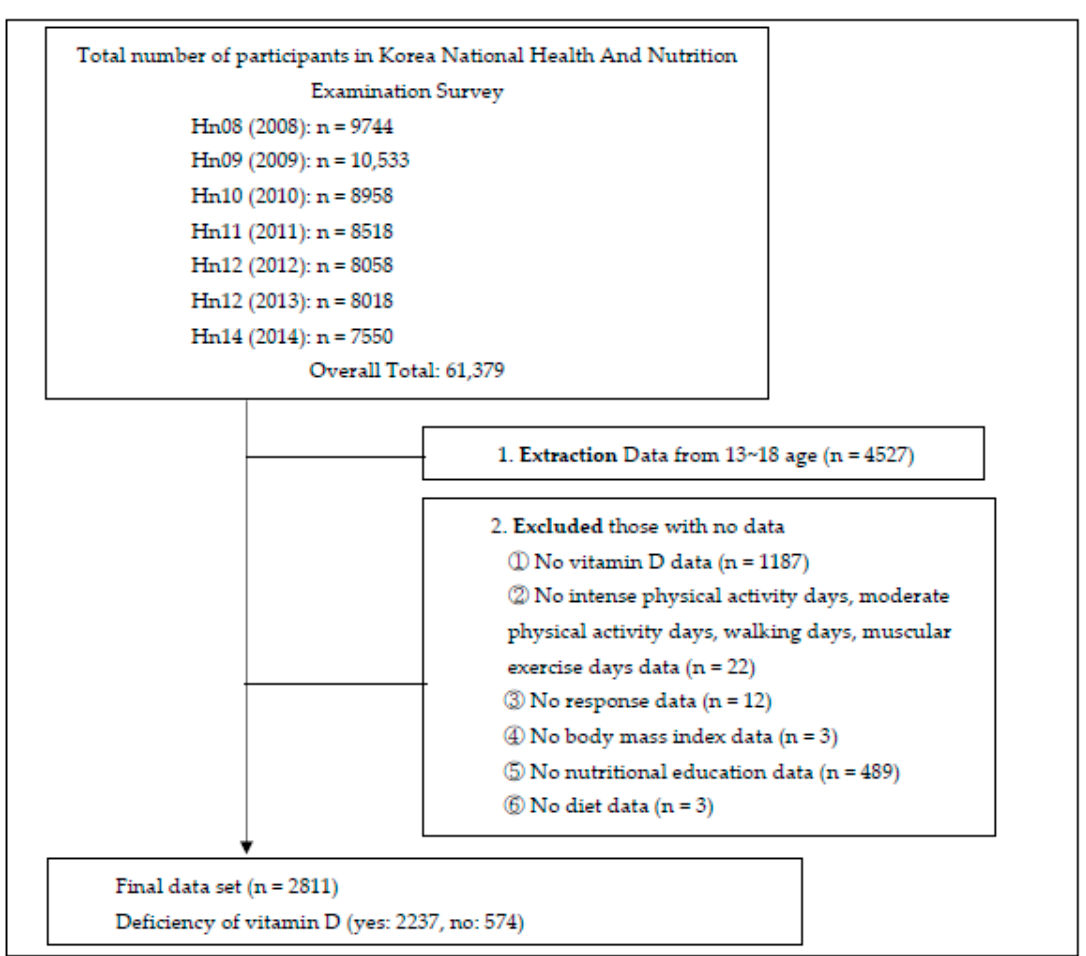
Figure 1. Flowchart of adolescents’ selection from the Korea National Health and Nutrition Exami- nation Survey database.